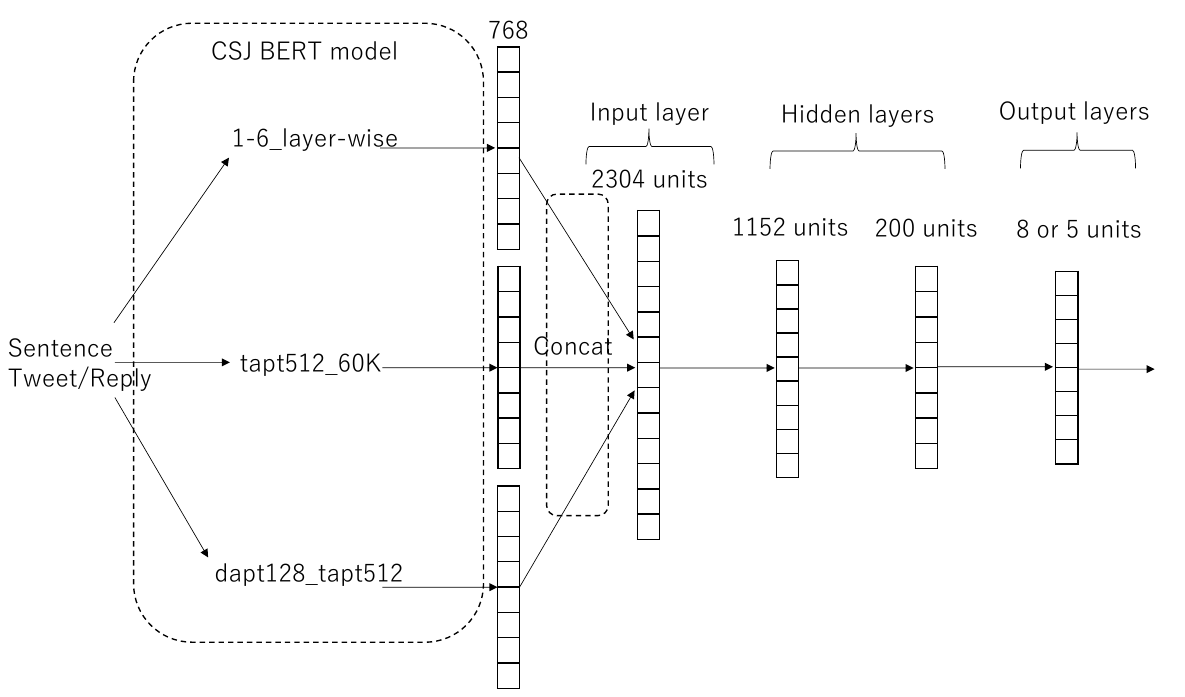
Figure 1. Emotion estimation networks for estimating eight emotions/five emotions. Rectified linear unit (ReLU) was used for the middle layer activation function, and Softmax was used for the output layer activation function. The ReLU is an activation function with an output value of 0 when the input value is less than 0, and the output value is the same as the input value when the input value is over 0. Equation (1) shows the formula for the ReLU: